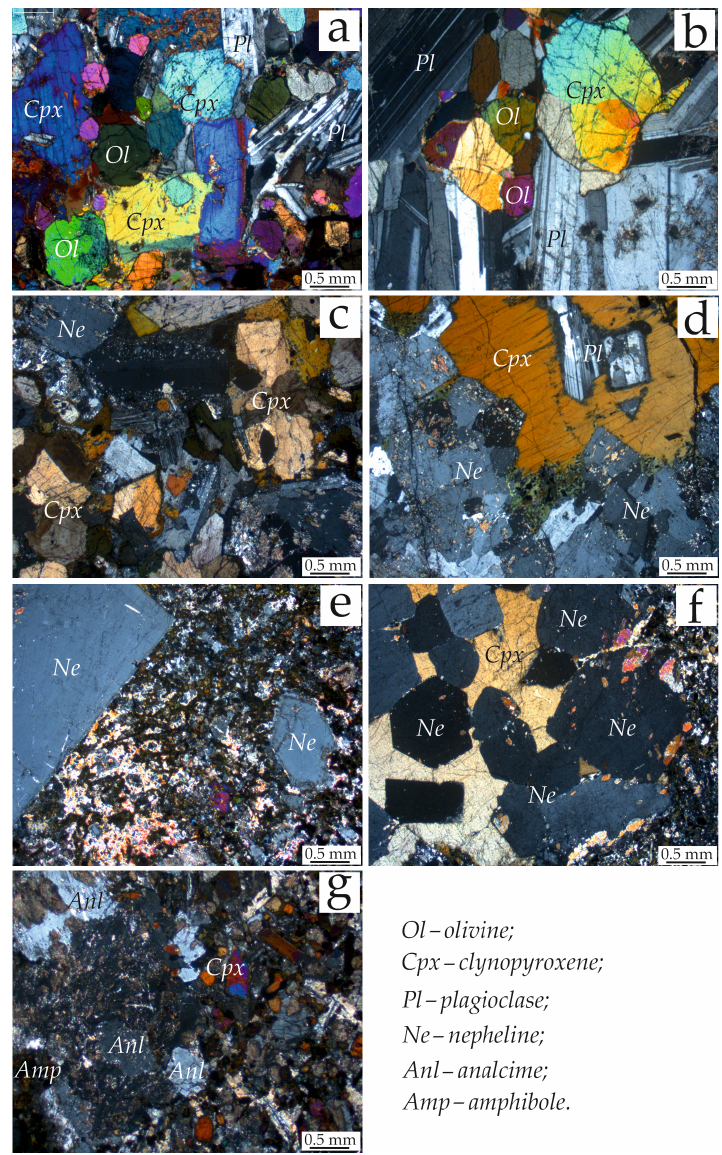
Figure 5. Photomicrographs of samples from the University pluton and crosscutting N-trending dikes: ( a , b ) subalkaline melanogabbro (sample C36/147.0) and leucogabbro (sample C41/87.0) mainly consist of clinopyroxene, plagioclase and olivine in different proportions and are characterized by a hypidiomorphic to ophitic structure; and the crosscutting N-trending dikes: ( c ) plagioclase ijolite (sample 6A) consists of nepheline, clinopyroxene, plagioclase and titanomagnetite with a distinct hypidiomorphic granular texture; ( d ) leucotheralite (sample 8A) consists of nepheline, clinopyroxene and plagioclase and is represented by a hypidiomorphic granular texture and ( e , f ) ijolite-porphyry (sample 8/19) and urtite xenolith in ijolite-porphyry (sample KC-7/1) are composed of nepheline and clinopyroxene in different proportions and are represented by a porphyry texture. The matrix of ijolite porphyry in which the urtite xenolith is placed is represented by a microhypidiomorphic-grained texture; ( g ) analcime syenite (globule) in fine-grained ijolite (sample 7A) consists of analcime, alkaline feldspar and amphibole with a hypidiomorphic-grained texture.